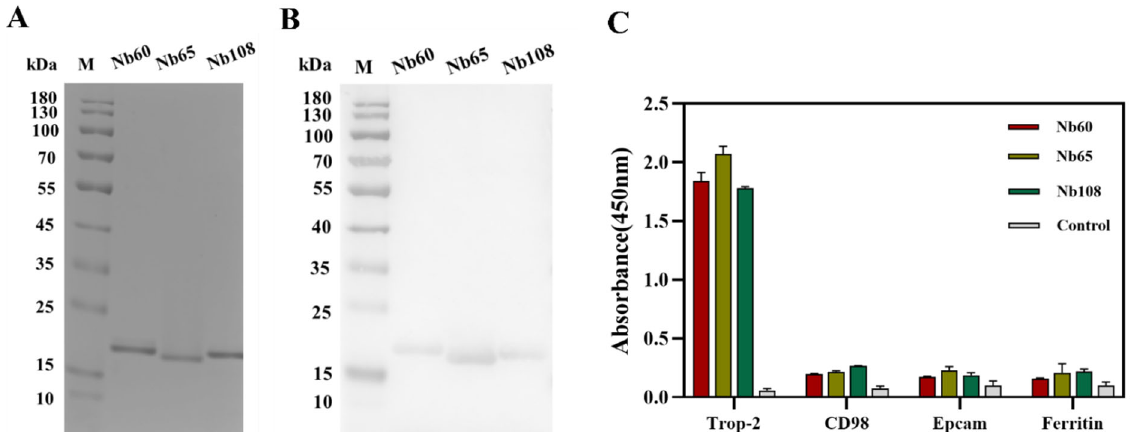
Figure 2. Purification and characterization of the selected Nbs. ( A ) The purity and molecular size of the selected Nbs were verified by SDS ‐ PAGE. ( B ) Western blot analysis was used to confirm the His ‐ tagged Nbs after expression and purification by IMAC and SEC. ( C ) Indirect ELISA was performed to confirm the binding ability and cross ‐ reactivity of the selected Nbs with irrelevant targets (CD98, EpCAM, and Ferritin). All the data are presented as the mean ± standard deviation (n = 3). Each experiment was repeated at least three times.